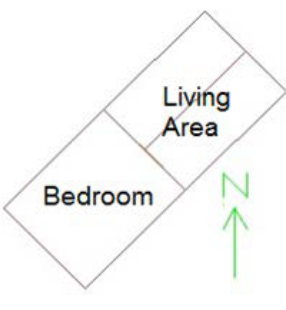
Figure 3. 60-m 2 experimental building—plan, orientation.